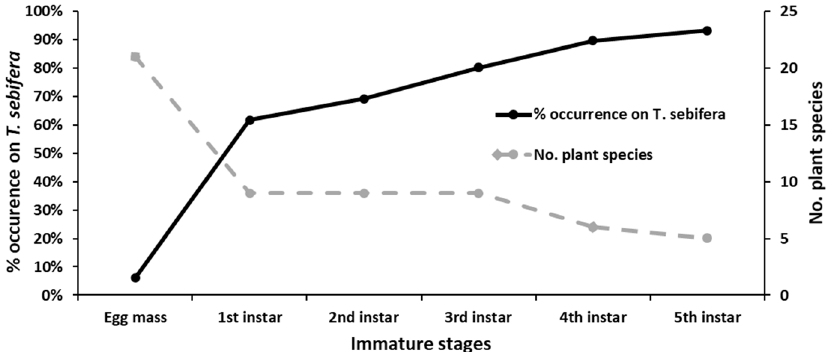
Figure 3. Host plant preference of immature stages from the egg mass to 5th instar of Pyrops candelaria . “No. plant species”: The number of plant species with >0.5% of egg masses or nymphs (all insatrs) was recorded.